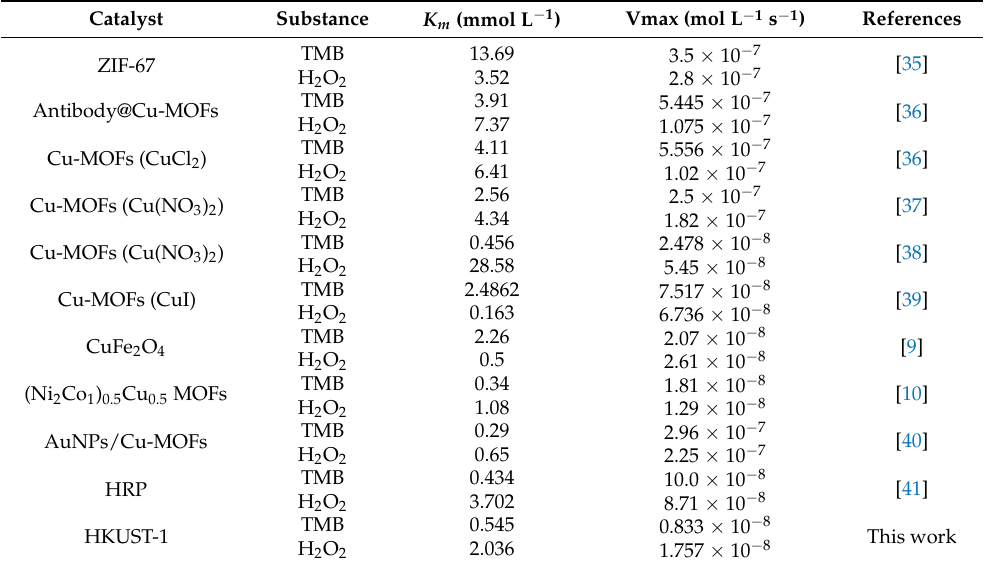
Table 1. Comparison of the Michaelis–Menten ( K m ) constant and maximum reaction rate ( V max ) of